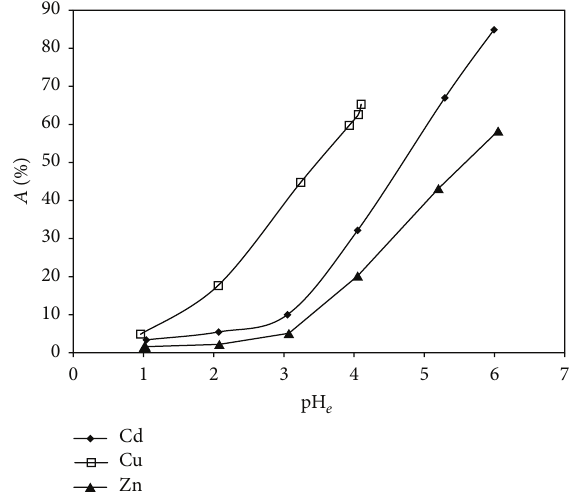
Figure 3: Effect of pH in the adsorption of Cd (II), Cu (II), and Zn (II) onto Aminated Desmostachya bipinnata (ADBP).